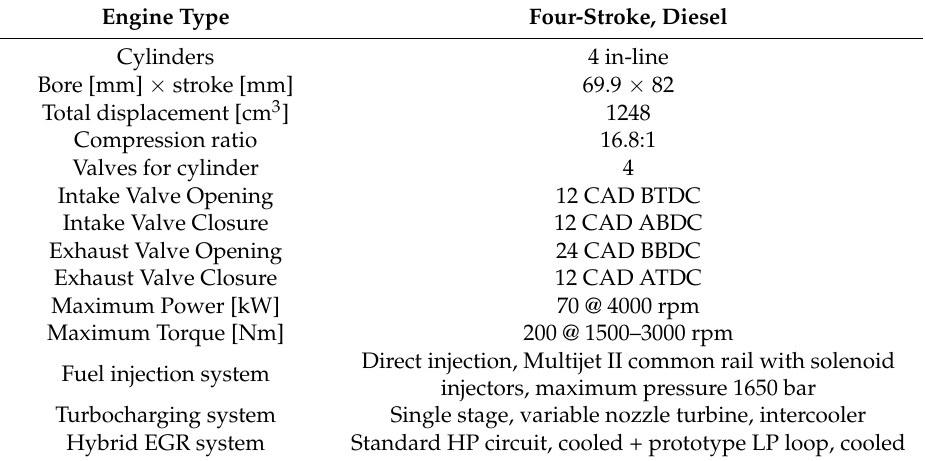
Table 1. Characteristics of tested